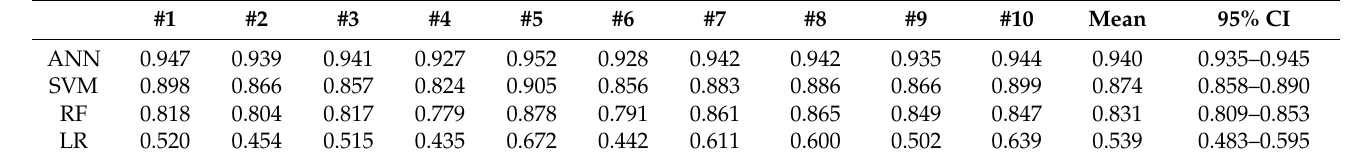
Table 3. Classifier accuracies for each subject and machine learning method.